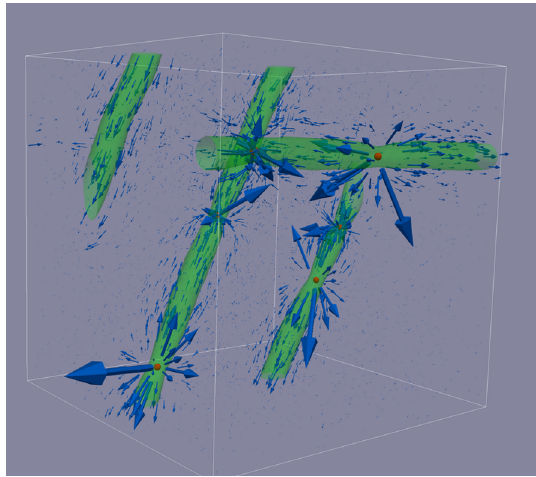
Figure 7 . The snapshot of the necklace in the dark sector at the simulation end, ηv 1 = 79 . 0 , with the parameter set II in table 1. The red and green surfaces are the isosurface of | φ | φ 2 | = v 2 / 2 , respectively. The blue arrow represents the U(1) D magnetic field computed by eq. (4.3). The drawing points for the blue arrows are chosen randomly, so if the drawing points are close to the monopoles, the corresponding arrows are accidentally large. This figure shows the magnetic fields around the strings are well aligned to them, while the configuration around the monopoles becomes like a hedgehog